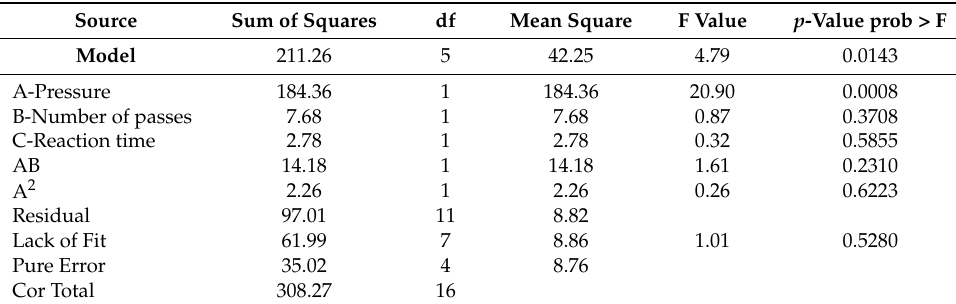
Table 3. Analysis of variance (ANOVA)